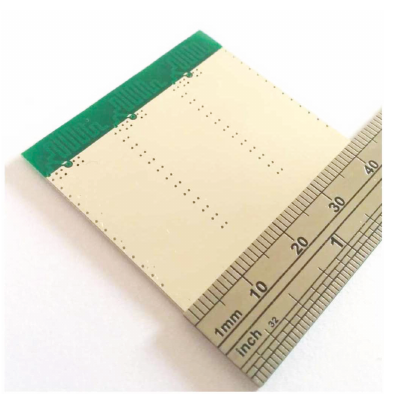
Figure 2: Printed inverted-F antenna (PIFA).